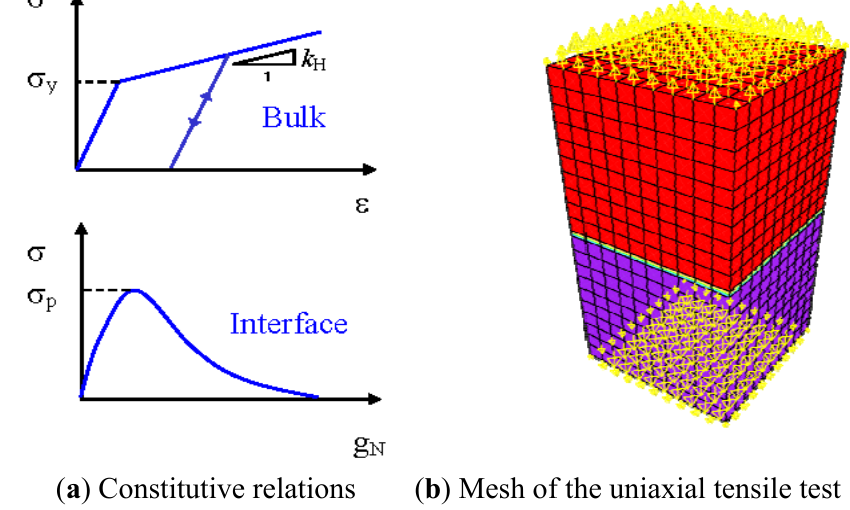
Figure 3. ( a ) Constitutive relations for the bulk and the interface and ( b ) mesh of the 3D uniaxial tensile test.